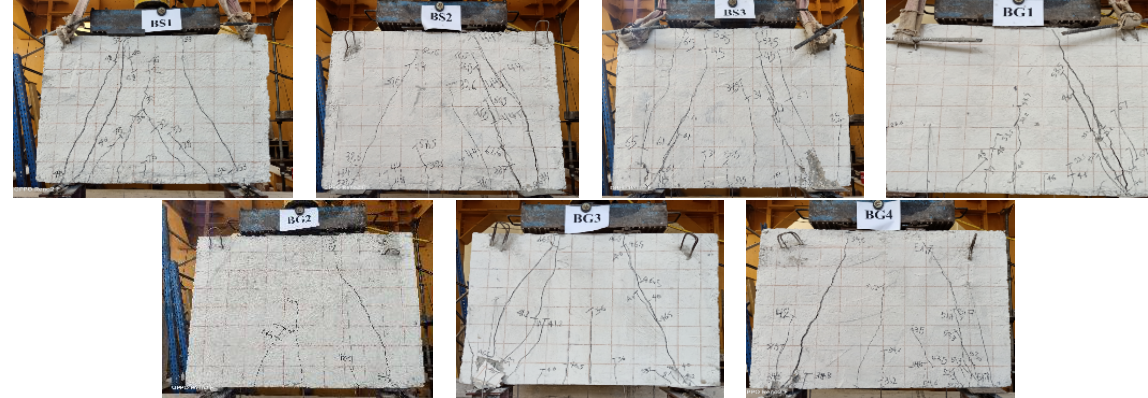
main diagonal crack. Still, the concrete beam with a GFRP